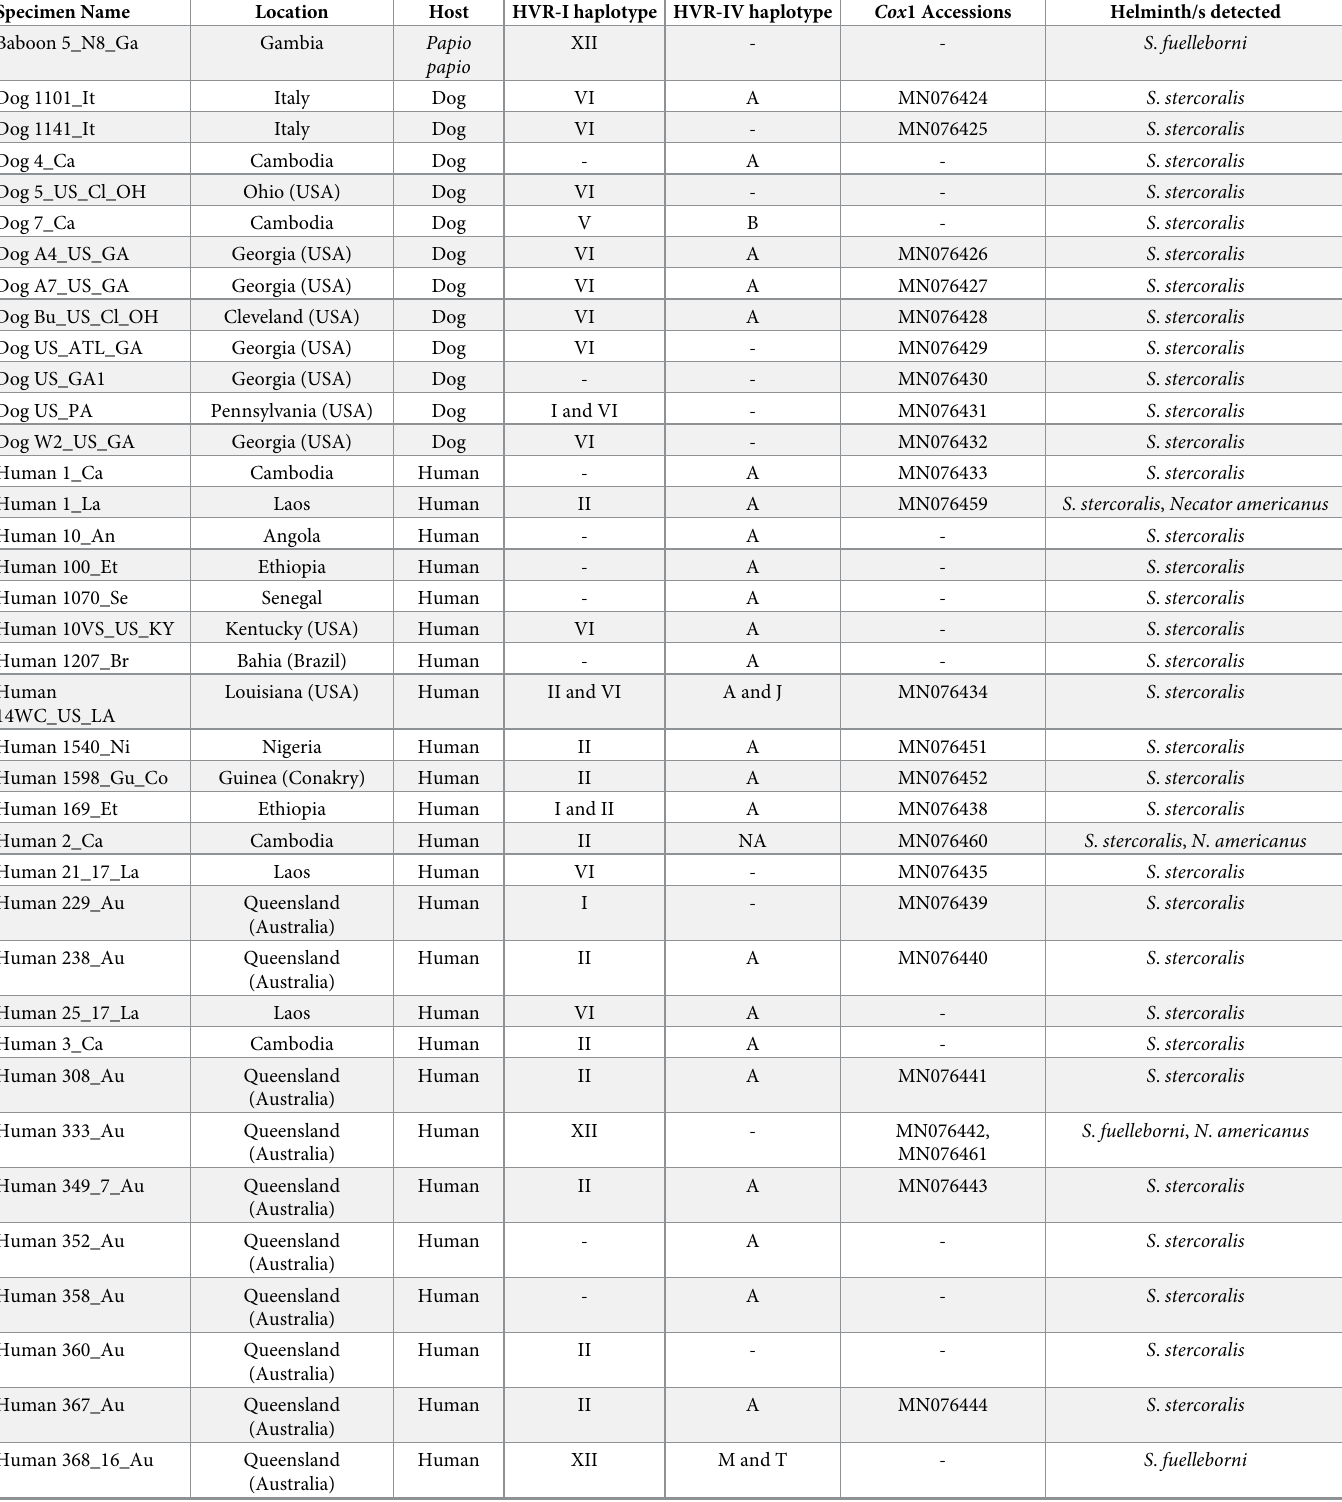
Table 4. Human, primate and dog Strongyloides spp. specimens analyzed in this study and their genotype. Specimen